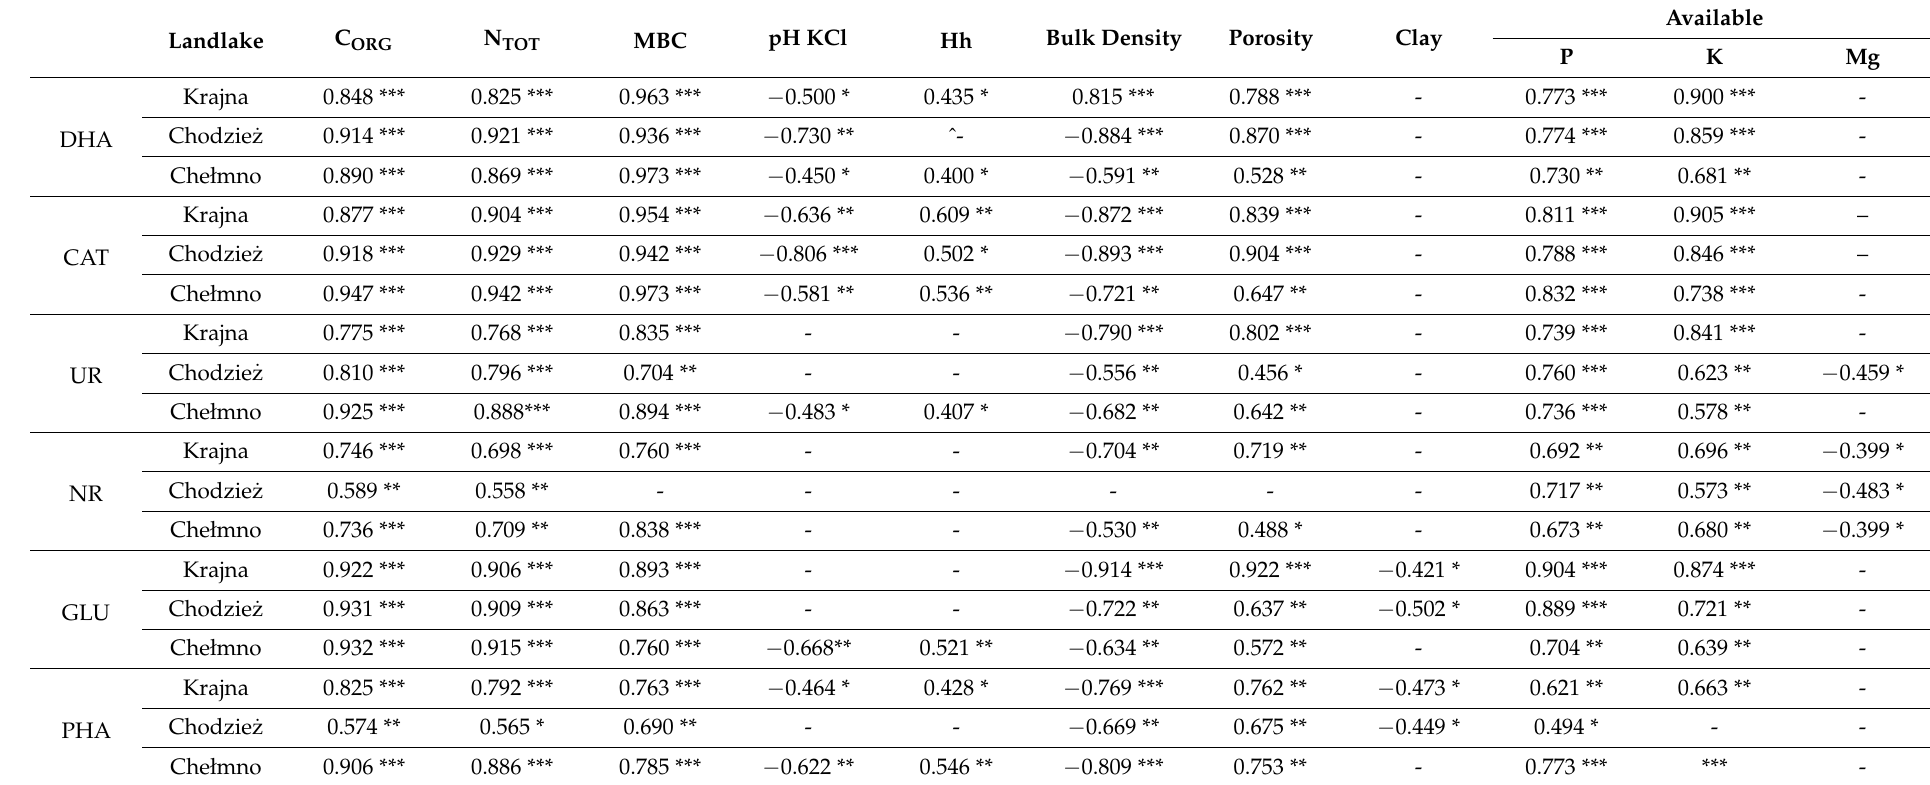
Table 5. Correlation matrix between studied properties (n =